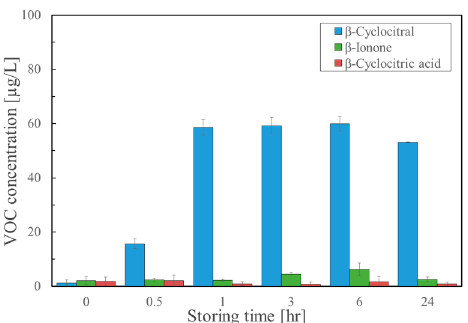
Figure 3. Analysis results of β -cyclocitral, β -ionone, and β -cyclocitric acid after acidification followed by storing for 0.5, 1, 3, 6, and 24 h ( n = 3).